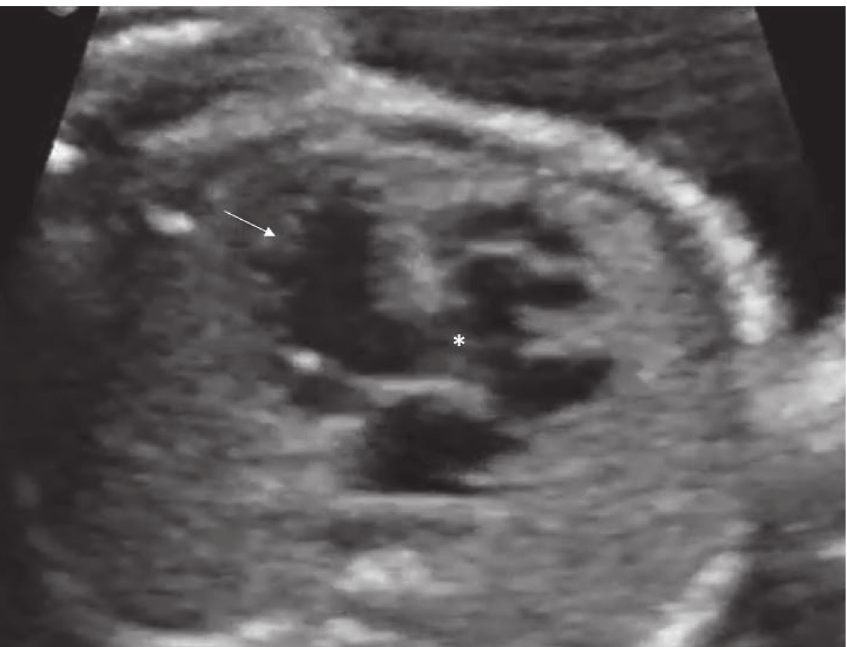
Figure 1: A 4-chamber view in a fetal echocardiogram showing a heavily trabeculated spongy looking LV suggestive of non-compaction (arrow). It also shows the Ebstein’s anomaly and a VSD ( ∗ ) between the LV to the atrialized portion of the RV.